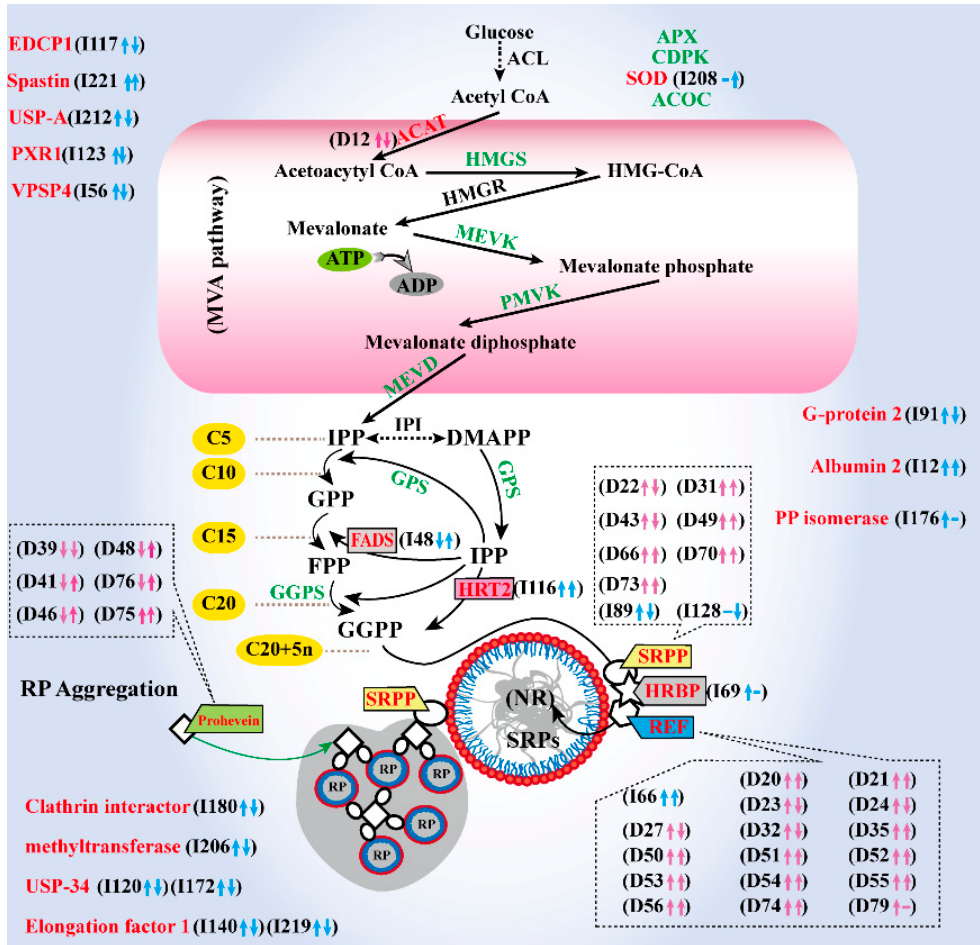
Figure 6. Schematic diagram of SRP proteins involved in natural rubber biosynthesis (NRB). A schematic diagram of enzyme localization and the regulation of ethylene-induced biochemical pathways on the protein level in SRPs are both highlighted. In this schematic diagram, the identified proteins involved in NRB from SRPs are marked with di ff erent colors (green, unchanged protein; red, changed protein), and the changed patterns determined by 2-D DIGE (D-) and iTRAQ (I-) for these DAPs are provided in the parentheses. The up arrow stands for upregulation, the down arrow stands for downregulation, and minus sign the protein is not significantly changed after ethylene